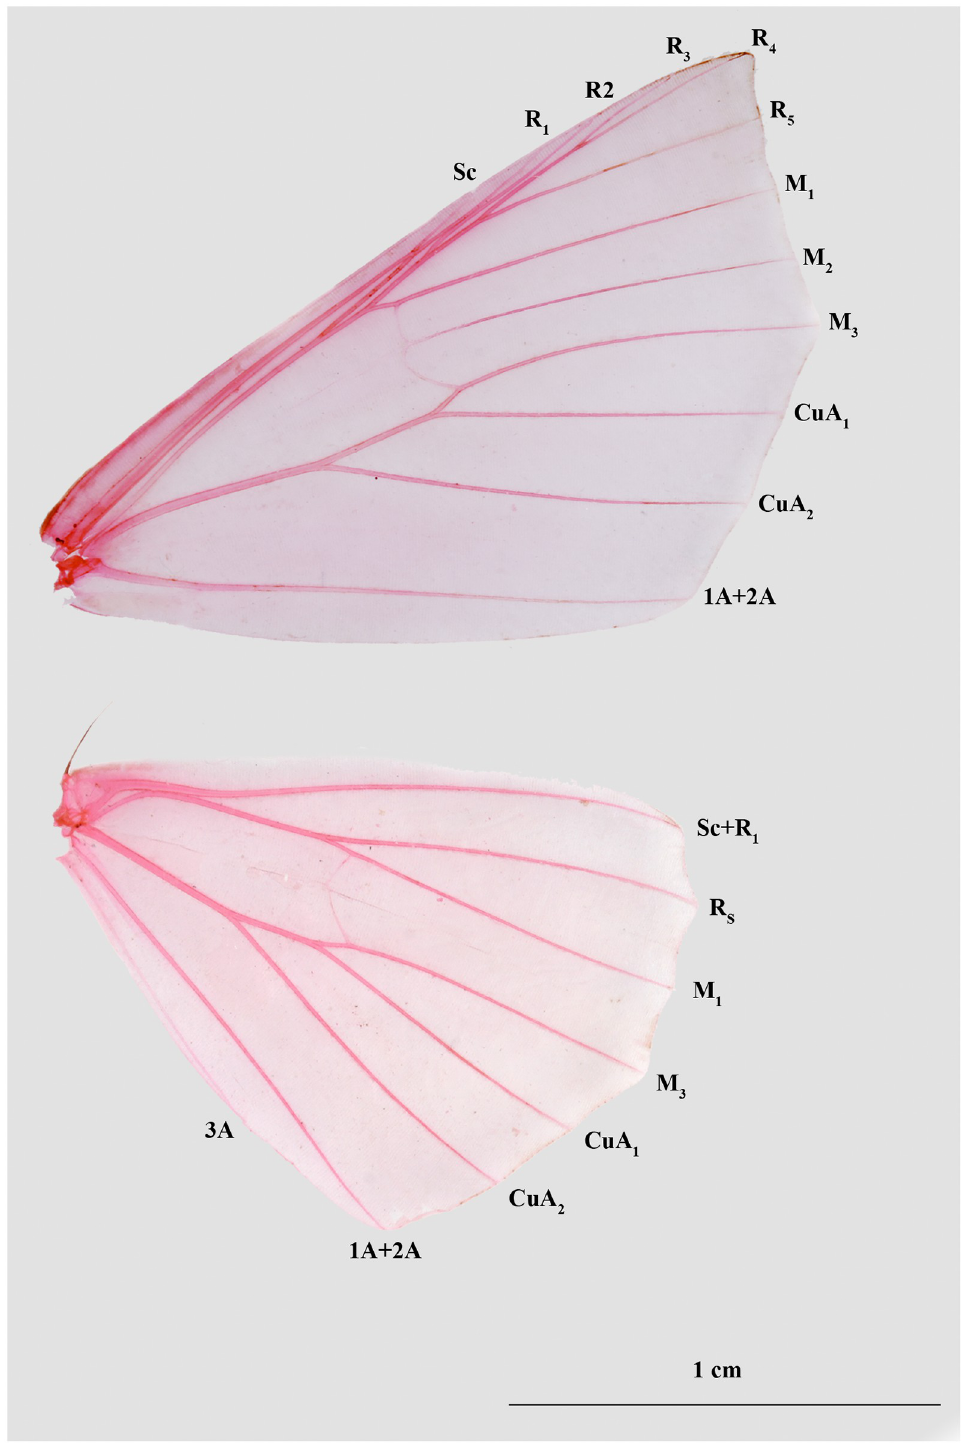
Fig 2. Forewing and hindwing venation of genus Psyra (of P . spurcataria ).